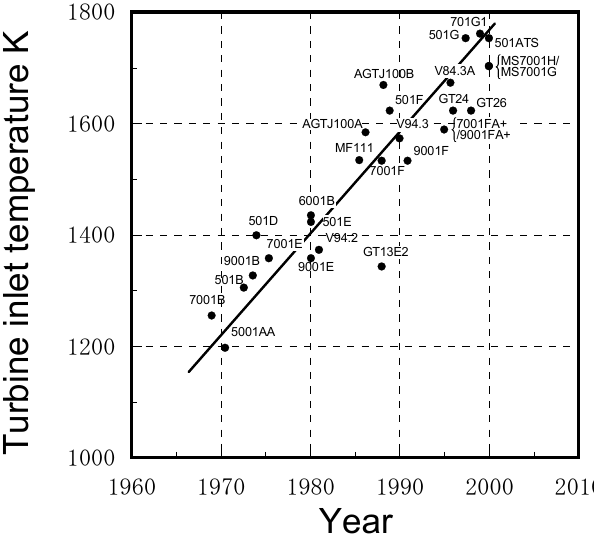
Figure 6. Transition of turbine inlet temperature of gas turbine combustor for electric power generation. (Signs indicate names of gas turbine models.)